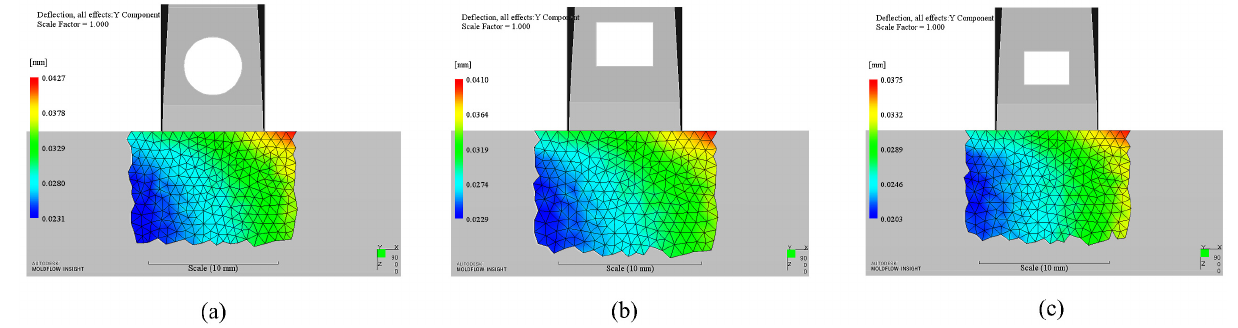
Figure 8. Deformation contour of supplementary cases: ( a ). Circular case located at the center of the optimized rectangular case with the same area as this rectangular; ( b ). Rectangular case with the same dimensions as the optimized rectangular case, but 1 mm farther; ( c ). Rectangular case located at the center of the optimized rectangular case, but 0.5 mm smaller in length and width.